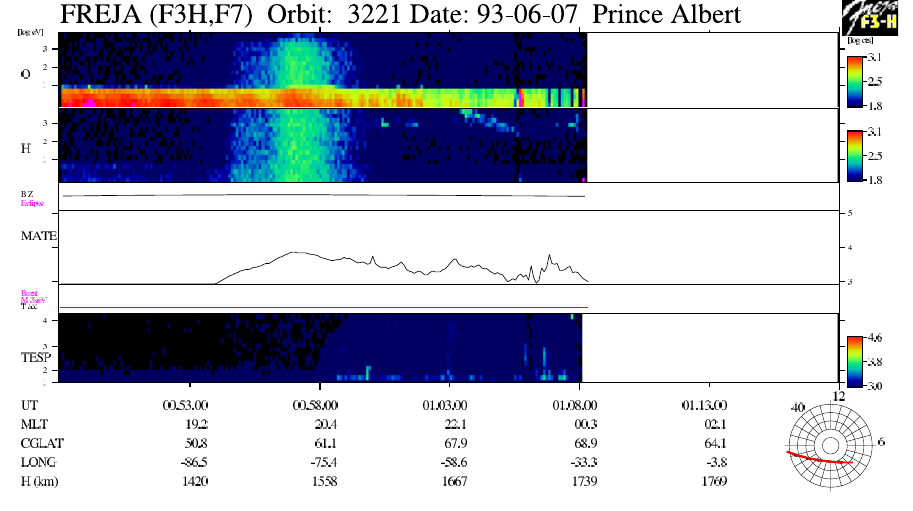
Fig. 13. A full pass CSP showing pre- cipitated ions with decreasing energy from 01:03:30UT to 01:05:30UT.